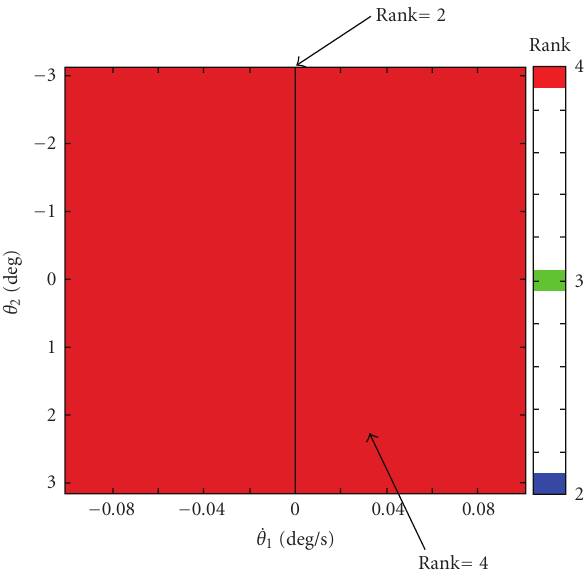
Figure 6: Rank of the controllability matrix U c at some positions x s ( ˙ θ 2 = 0, u =